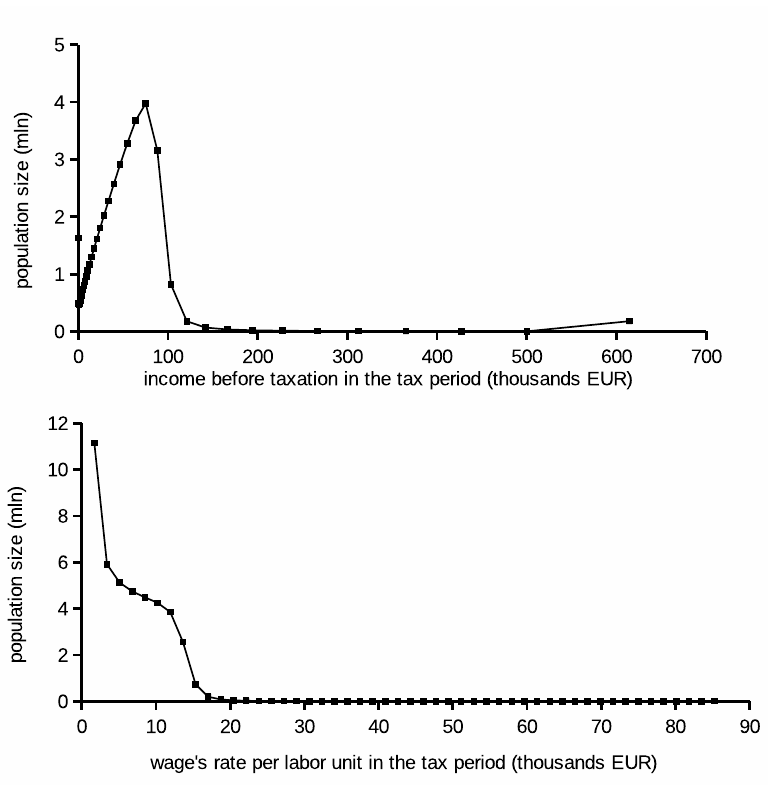
Figure 1. Redistribution and skills’